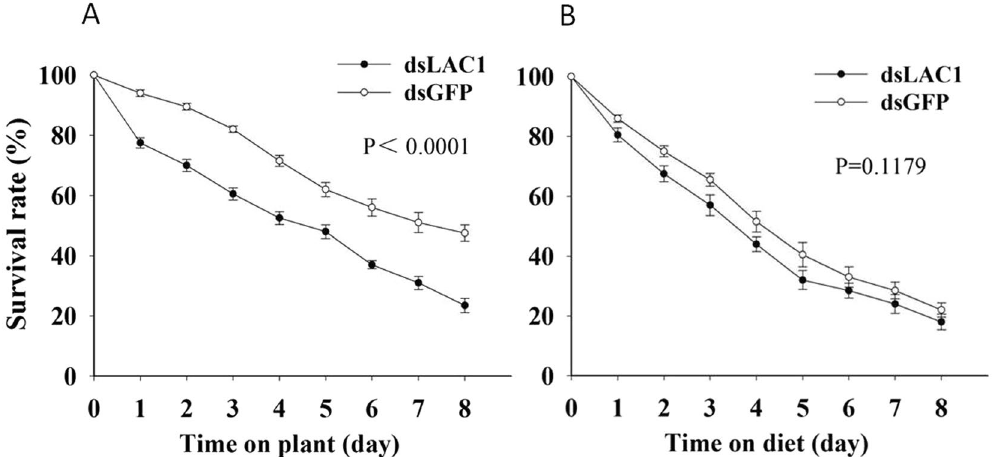
Figure 5. Knocking down LAC1 decreases the survival rates of B. tabaci adults. ( A and B ) Mean survival rates of B. tabaci adults that were fed dsRNA against LAC1 ( dsLAC1 ) or GFP ( dsGFP ) and then fed on tomato plants